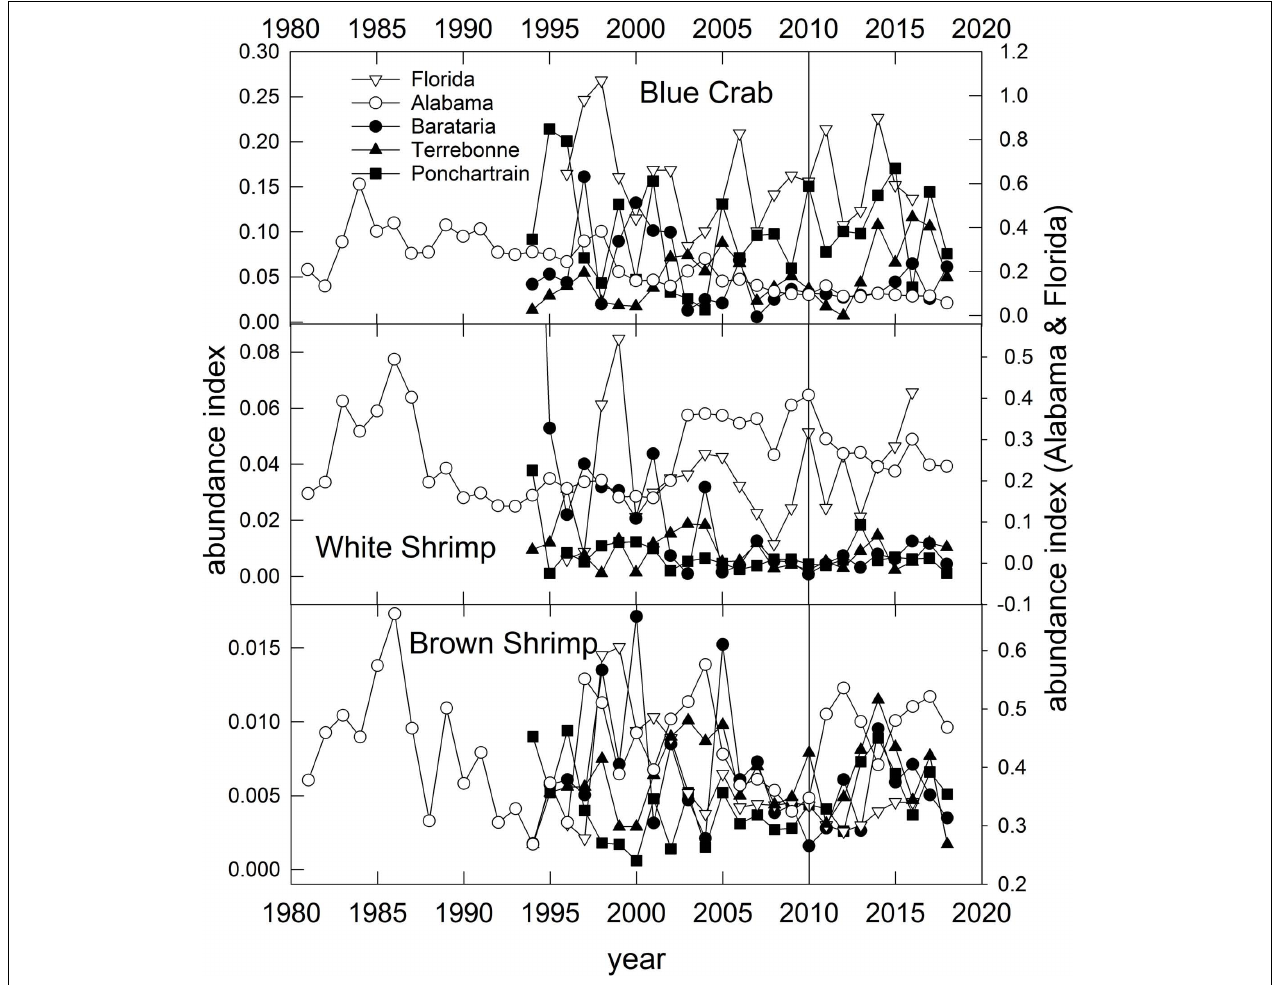
FIGURE 10 | Annual relative abundance indices for Blue Crab, White Shrimp and Brown Shrimp sampled from fisheries-independent trawl surveys conducted in three Louisiana basins, off Alabama and the Florida Panhandle ( Figure 1 ). Data are from the Alabama Marine Resources Department, the Louisiana Department of Wildlife and Fisheries and the Florida Fish and Wildlife Research Institute’s trawl survey